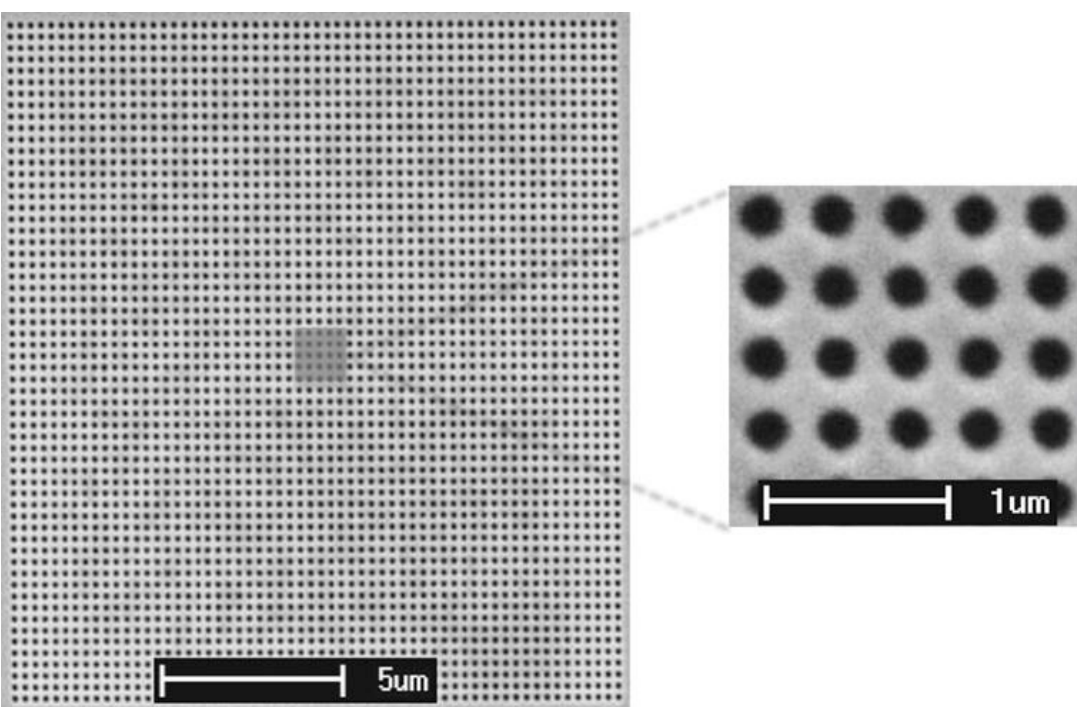
Figure 2. An array of gold nanohole measuring points used in microfluidic measurement. Reproduced with permission from [3]. Copyright 2015, Springer Science Business Media New York.